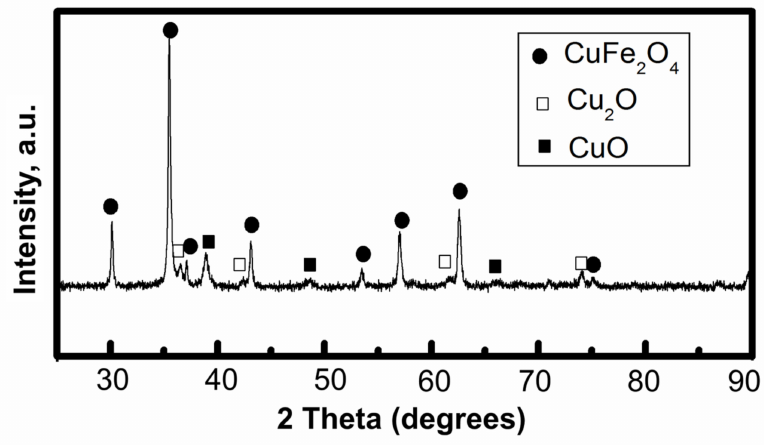
Figure 1. XRD pattern of CuFe 2 O 4 /Cu 2 O/CuO